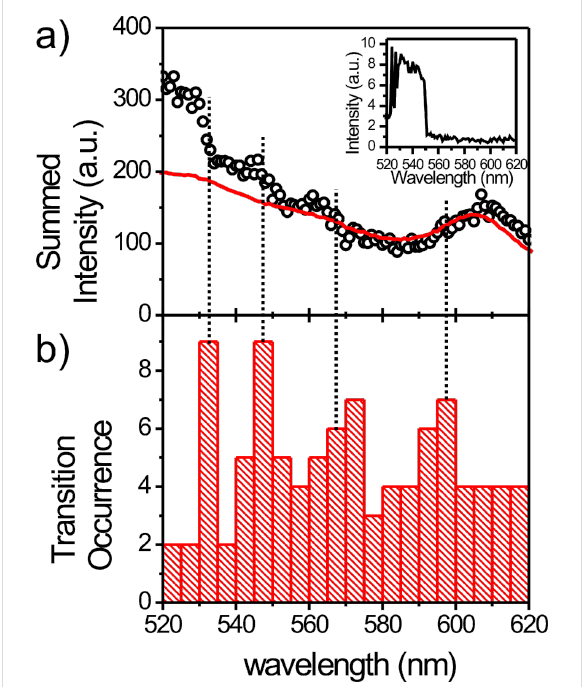
Figure 3: Single quantum dot excitation spectra reveal distinct excita- tion wavelengths with increased probability for a dark-state transition. a) sum spectrum of 48 excitation spectra of individual quantum dots (circles). Red: Ensemble excitation spectrum. Inset: Single quantum dot excitation spectra undergoing a transition to a dark state. b) Histogram of transitions to a long lived